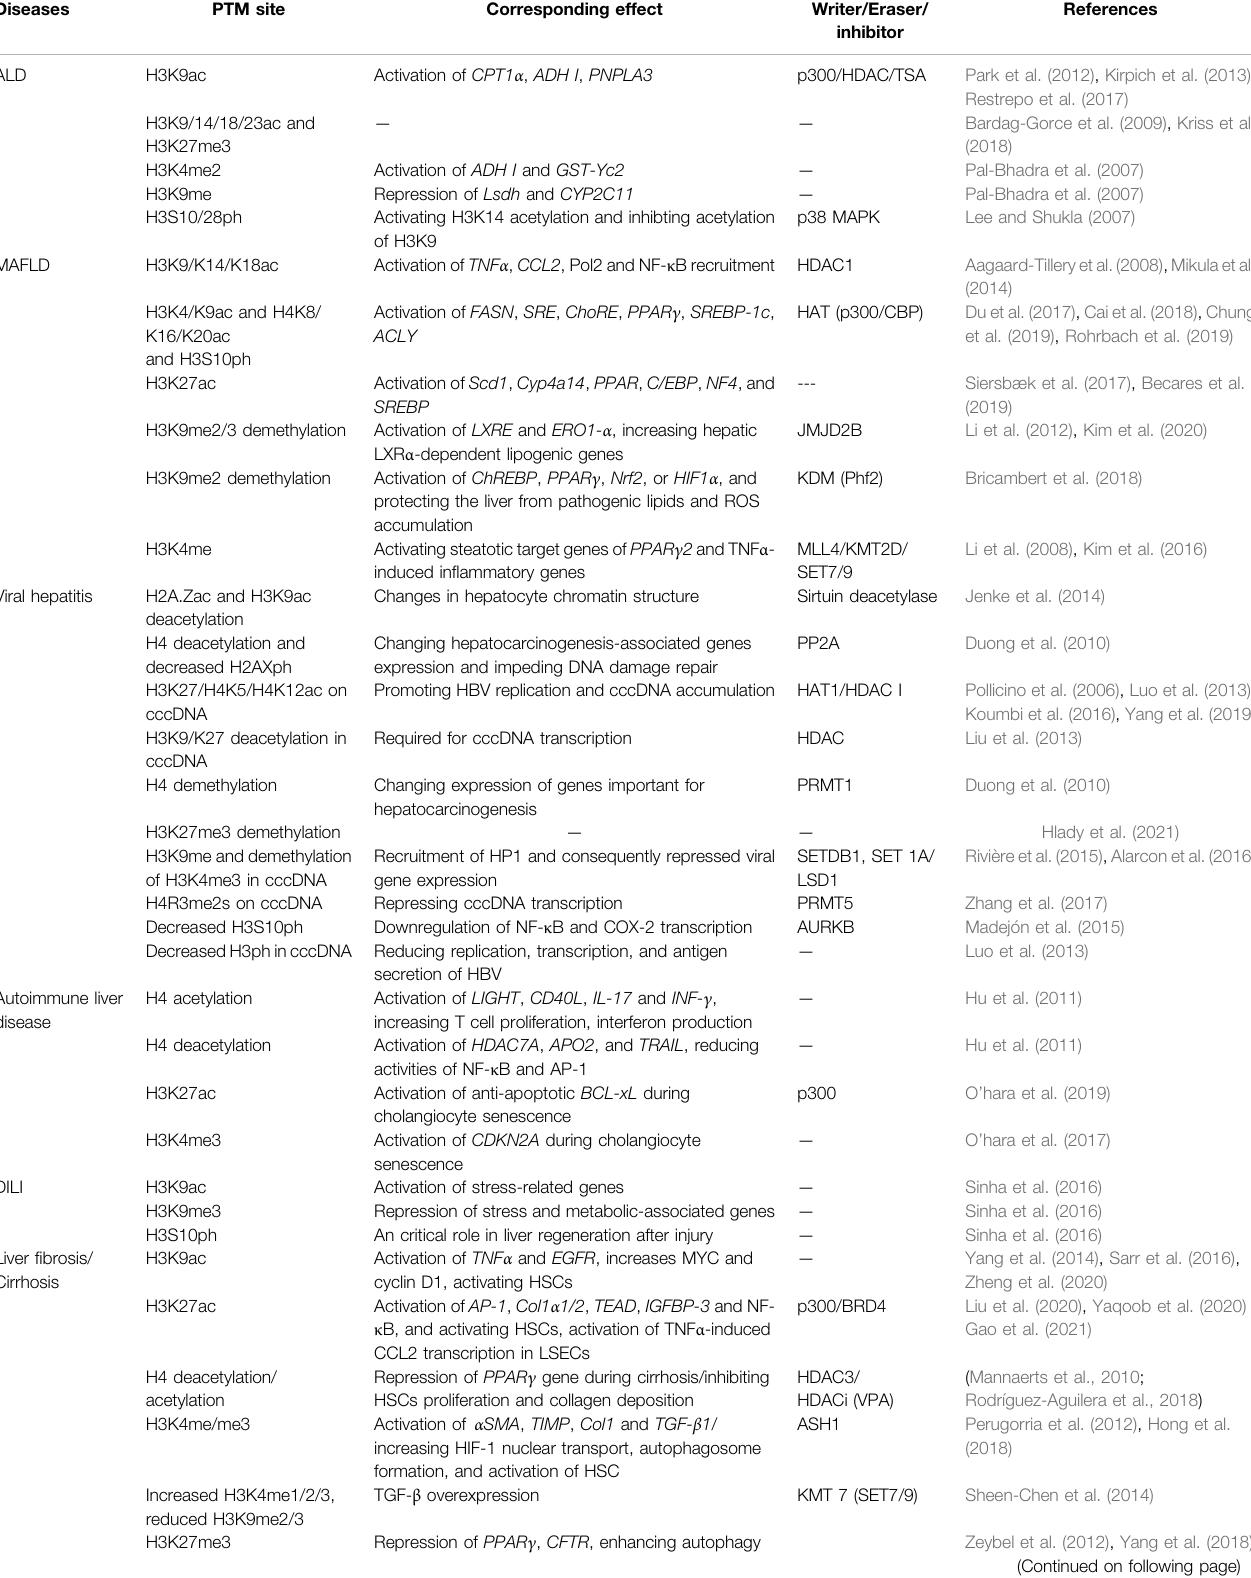
TABLE 1 | Summary of histone modi fi cations and the corresponding mechanisms involved in CLD.